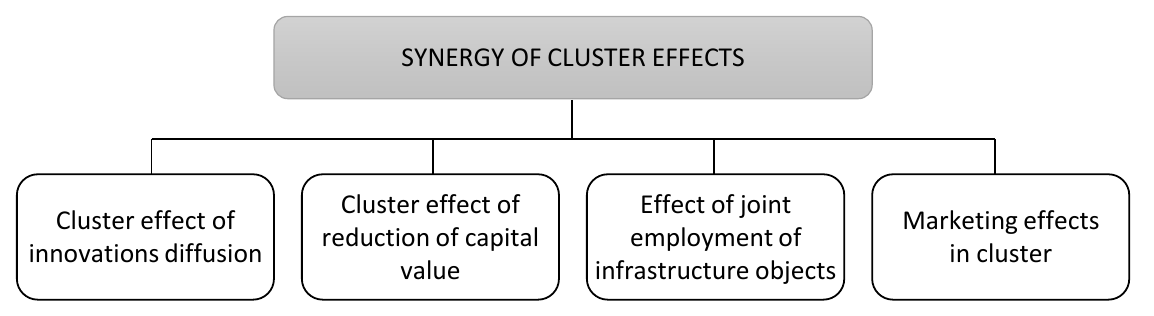
Figure 1. Synergy of cluster